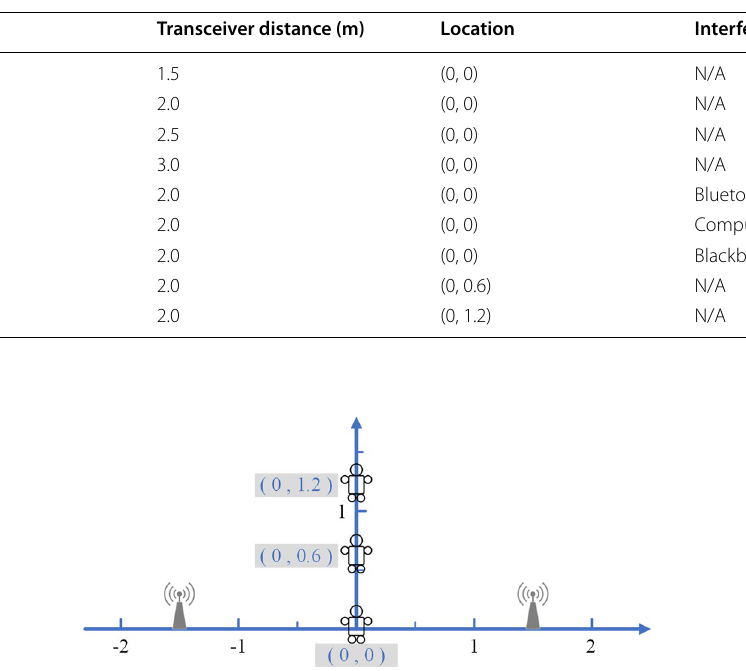
Table 1 Information of experimental samples